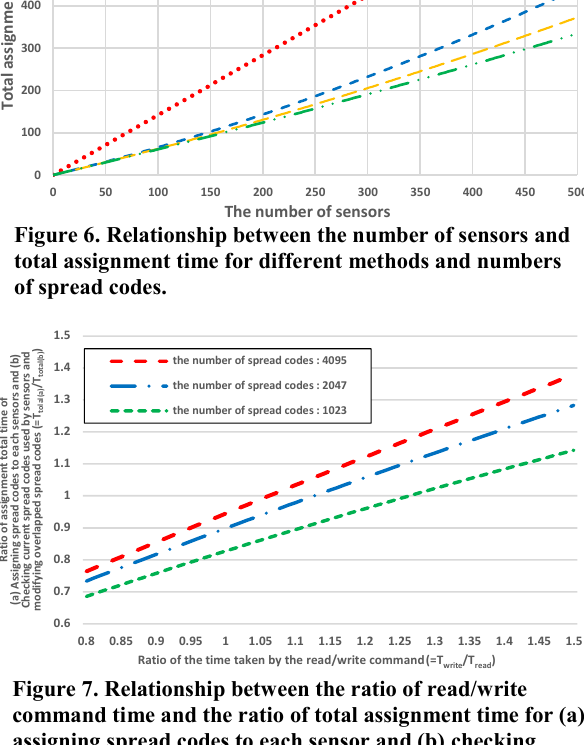
(b) Checking current spread codes used by sensors and modifying overlapped spread codes. (the number of spread codes : 1023) (b) Checking current spread codes used by sensors and modifying overlapped spread codes. (the number of spread codes : 2047) (b) Checking current spread codes used by sensors and modifying overlapped spread codes. (the number of spread codes : 4095)